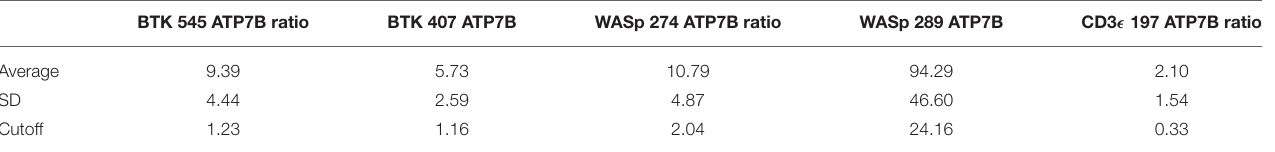
TABLE 9 | Cutoffs for signature peptides by the ratios against ATP7B